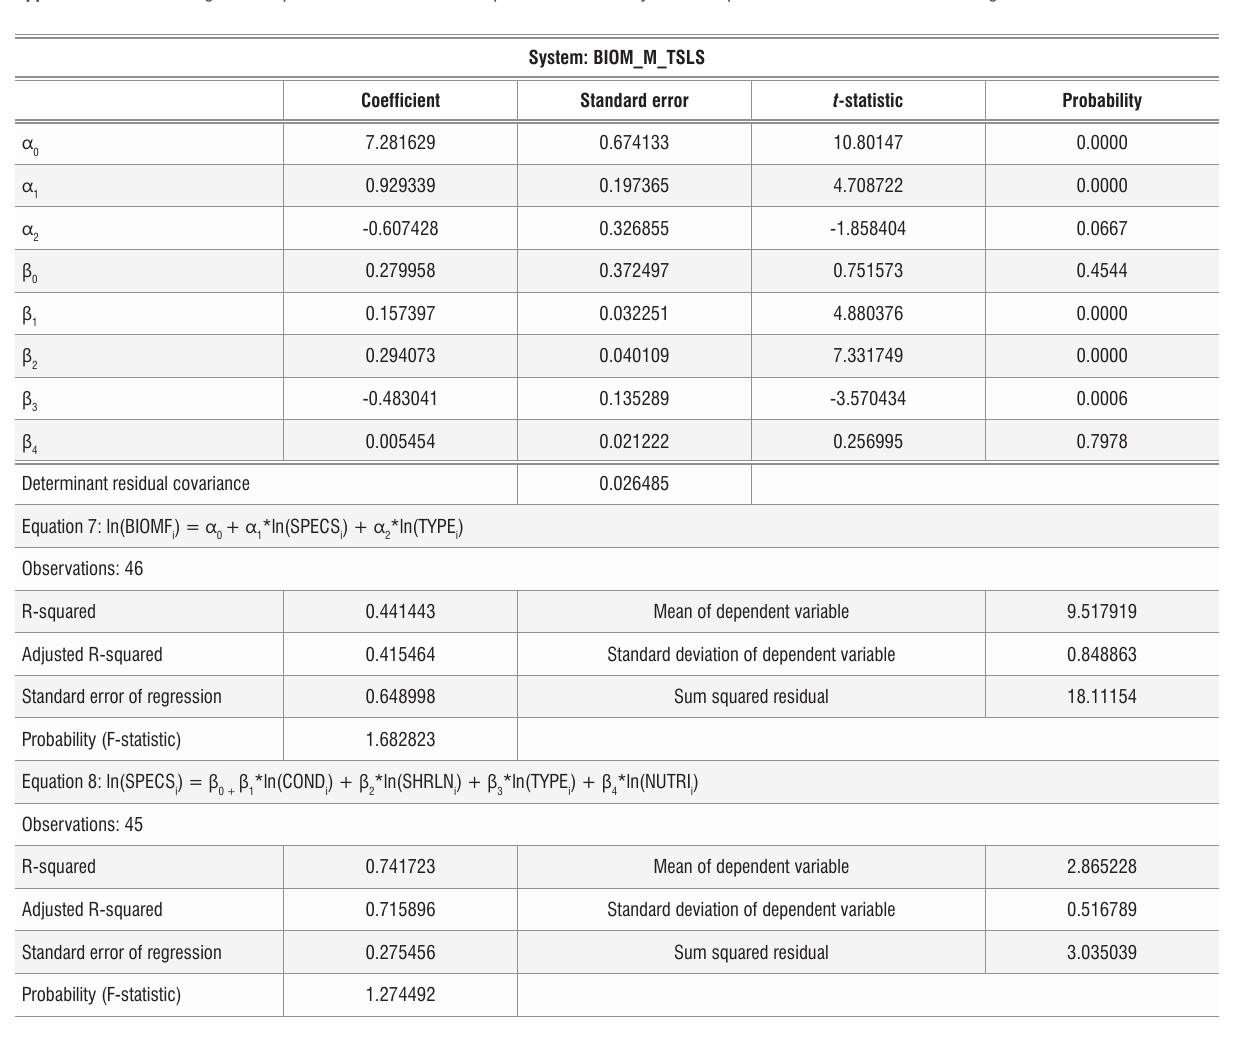
Two-stage least squares method estimates of parameters of the system of Equations 7 and 8 for the Cobb–Douglas